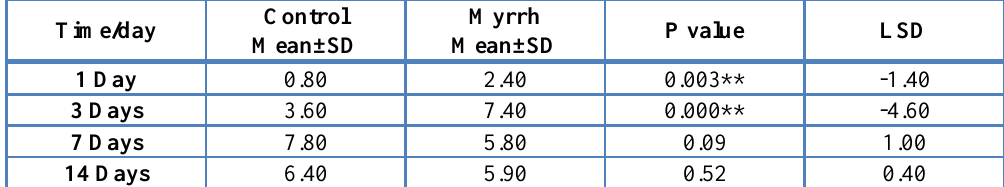
Table (5) Descriptive statistics of the collagen fiber density (%) in each period interval